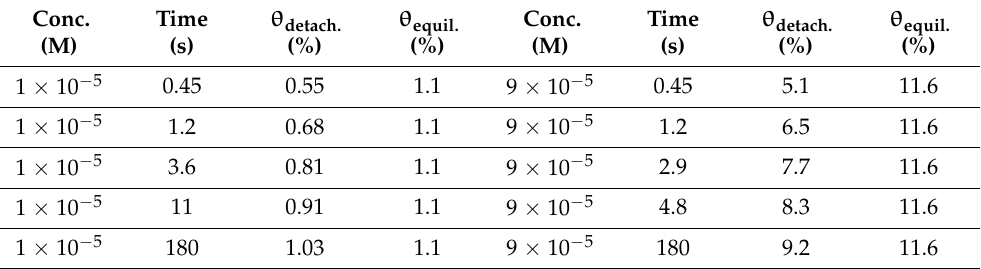
Table 2. Detaching and equilibrium adsorption coverages for n-octanol solutions of 1 × 10 − 5 M and 9 × 10 − 5 M for various adsorption times.